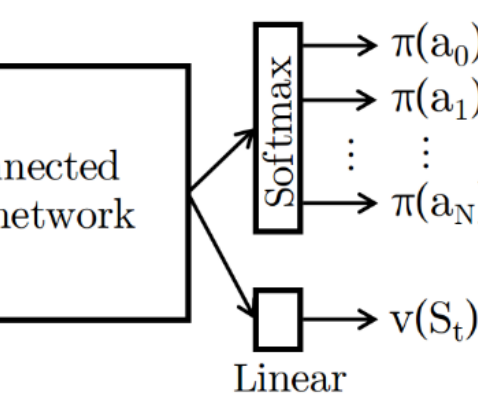
Figure 4. The policy and state-value function network